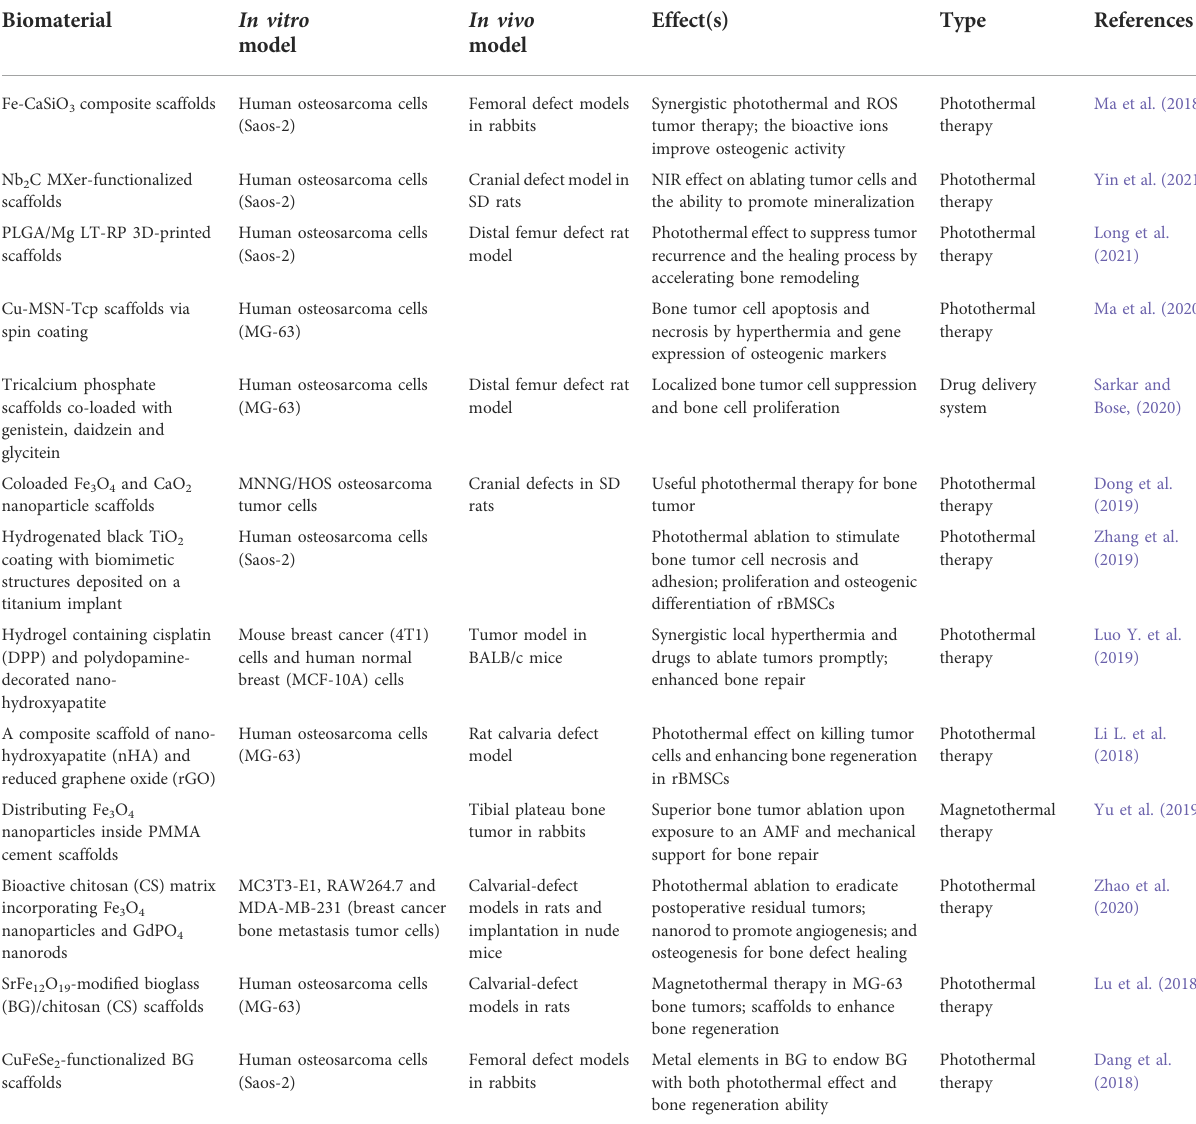
TABLE 1 Examples of biomaterial scaffolds used in bone tumor therapy and bone regeneration.